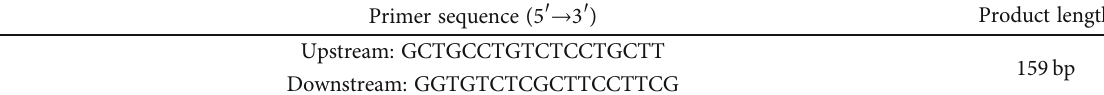
Table 1: Primer sequences.